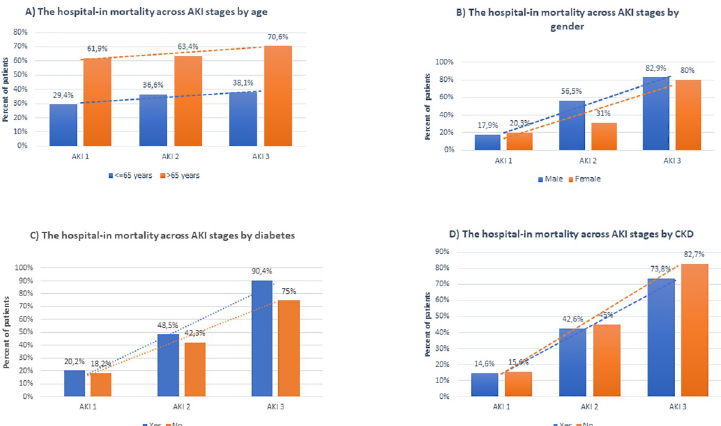
Fig 2. The in-hospital mortality rate across acute kidney injury (AKI) stages by age (A), gender (B), diabetes mellitus (C), and chronic kidney disease (CKD) (D).